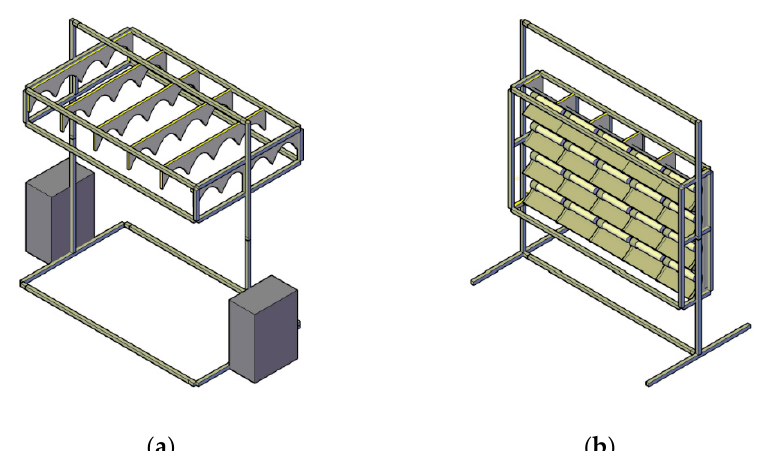
Figure 4. 3D view of the whole system: vertical flux configuration ( a ) and horizontal flux configuration ( b ).